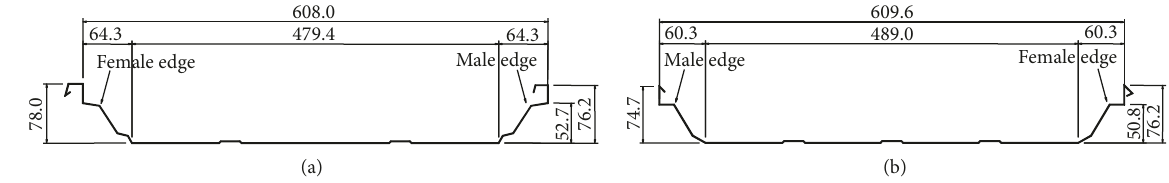
Figure 1: Dimensions of standing seam roof panels. (a) LSIII roof panel. (b) SS360 roof panel.